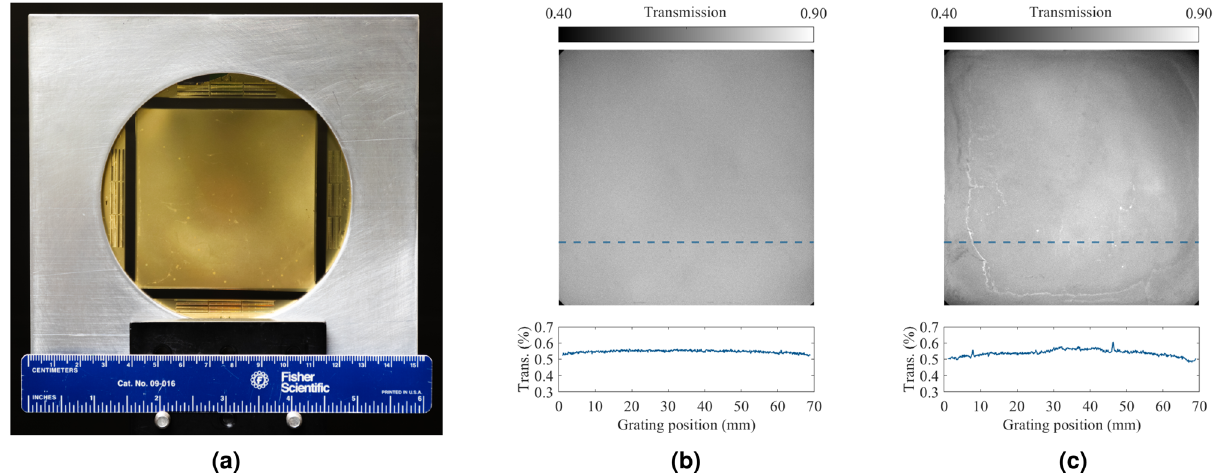
Figure 7. ( a ) Demonstration of a prototype large-area 70mm × 70mm grating fabricated on a 4-inch glass substrate. Transmission map at 60kV p of ( b ) a two-layer and ( c ) a three-layer 70 mm × 70 mm prototype X-ray absorption grating. The three-layer grating exhibits a few visible blemishes stemming from the third-layer electroplating.